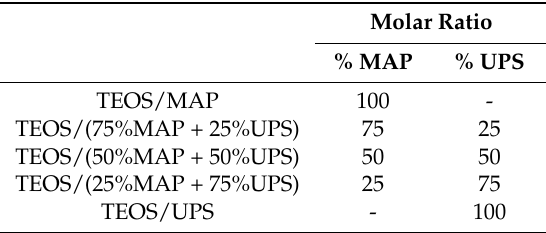
Table 1. Composition of the TEOS/(MAP + UPS)